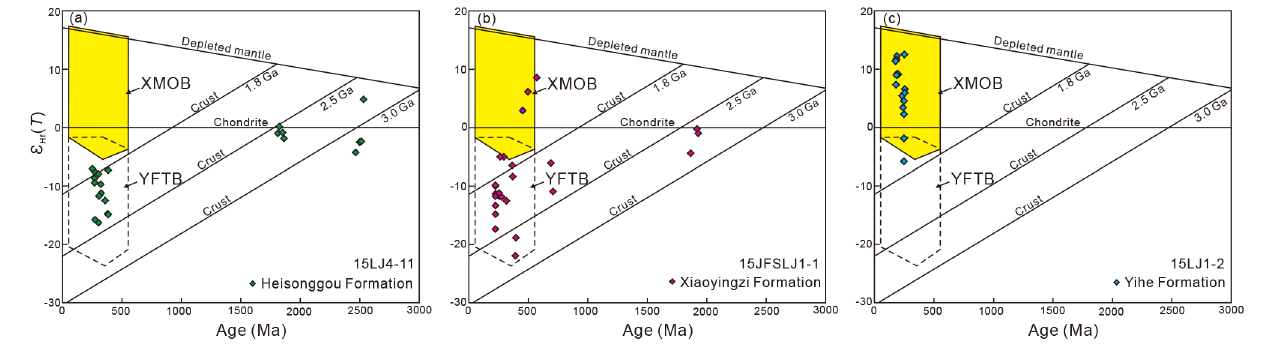
Figure 10. Hf isotopic compositions of detrital zircon grains from early Mesozoic strata of the northeastern NCC. XMOB: Xing’an–Mongolia Orogenic Belt; YFTB: Yanshan Fold and Thrust Belt (Yang et al.,